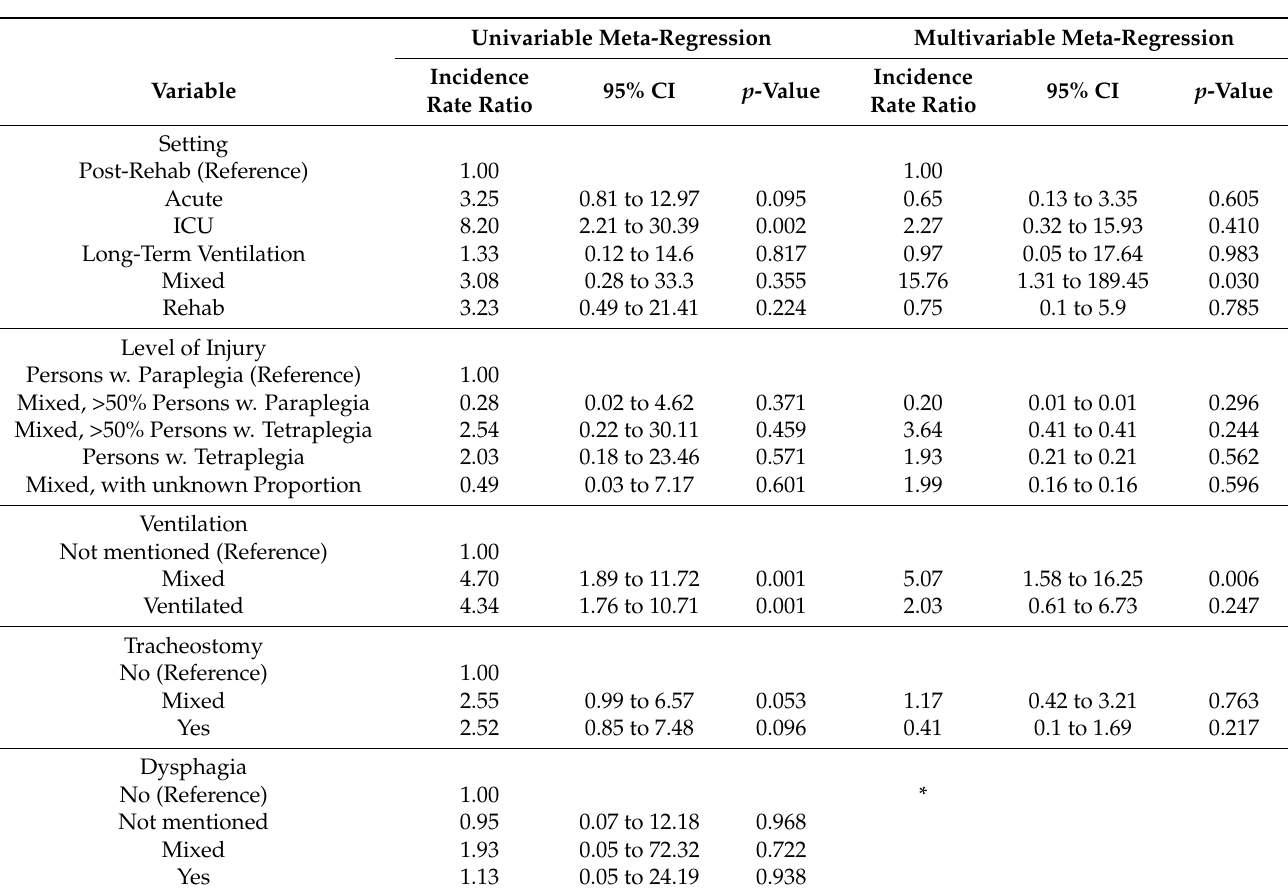
Table 2. Univariable and multivariable Meta-Regression including Setting, Level of Injury, Ventilation, Tracheostomy, and